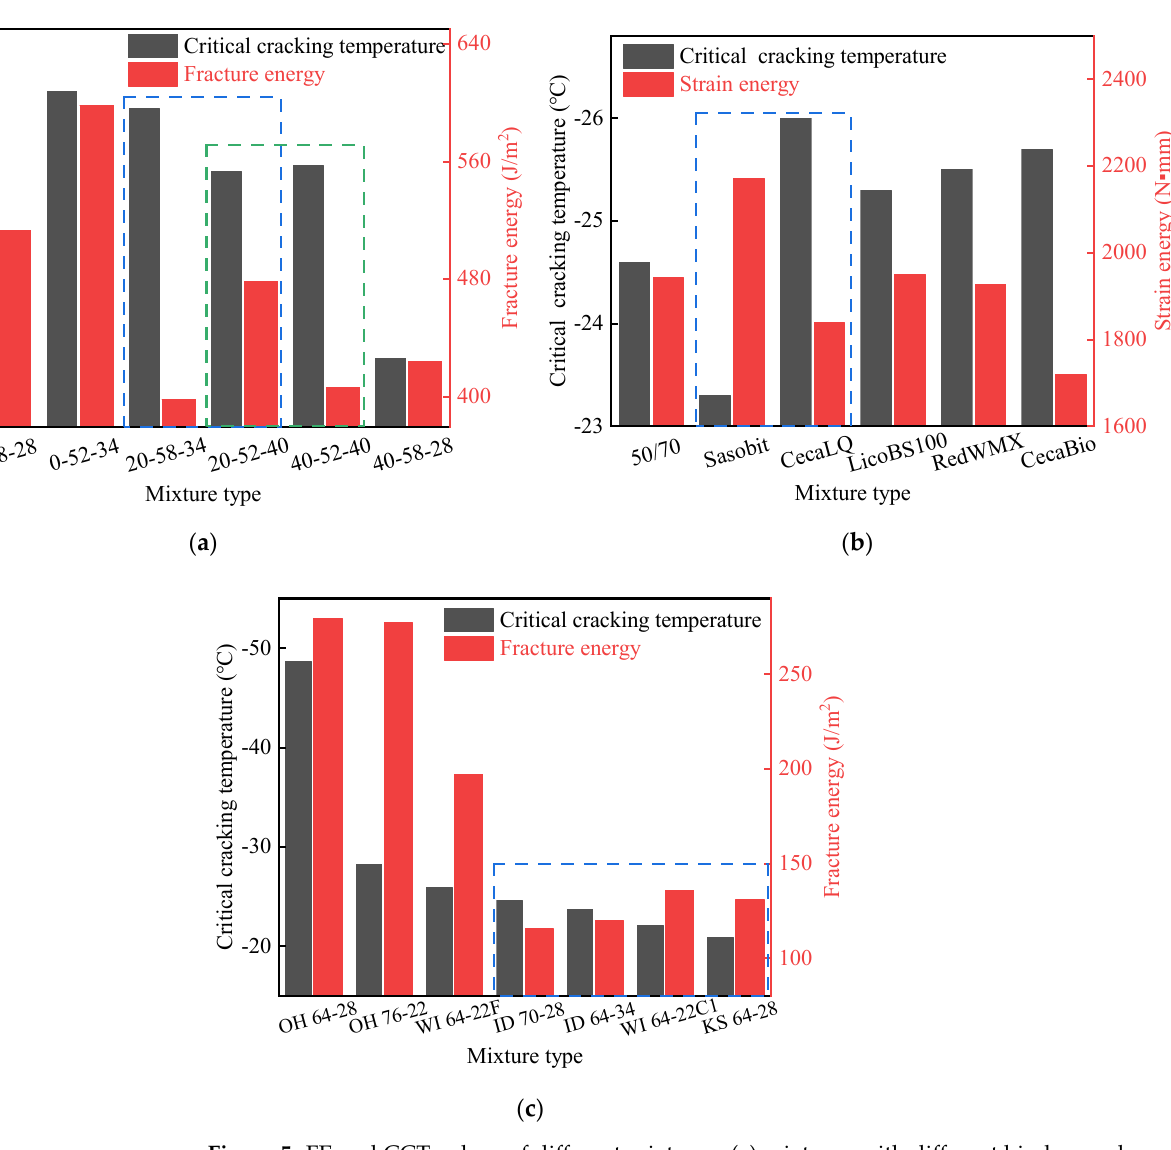
Figure 5. FE and CCT values of different mixtures: ( a ) mixtures with different binder grades and RAP contents derived from Sanchez et al. [5,50]; ( b ) mixtures with different additives derived from Stienss et al. [51]; ( c ) mixtures with different gradations derived from Mandal et al.